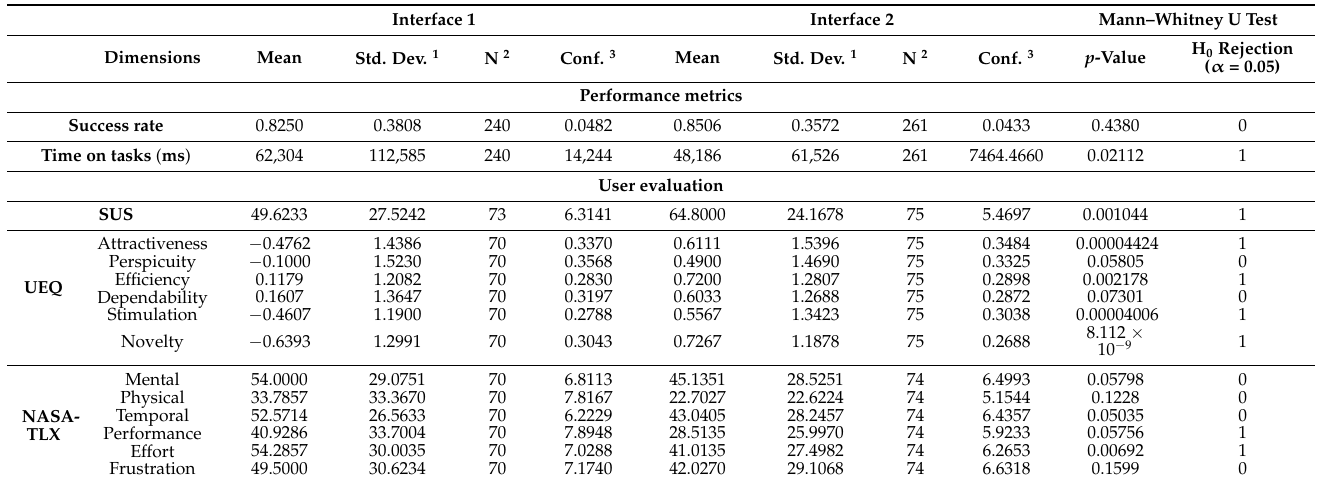
Table 3. Performance metrics and user evaluation for testing interfaces.